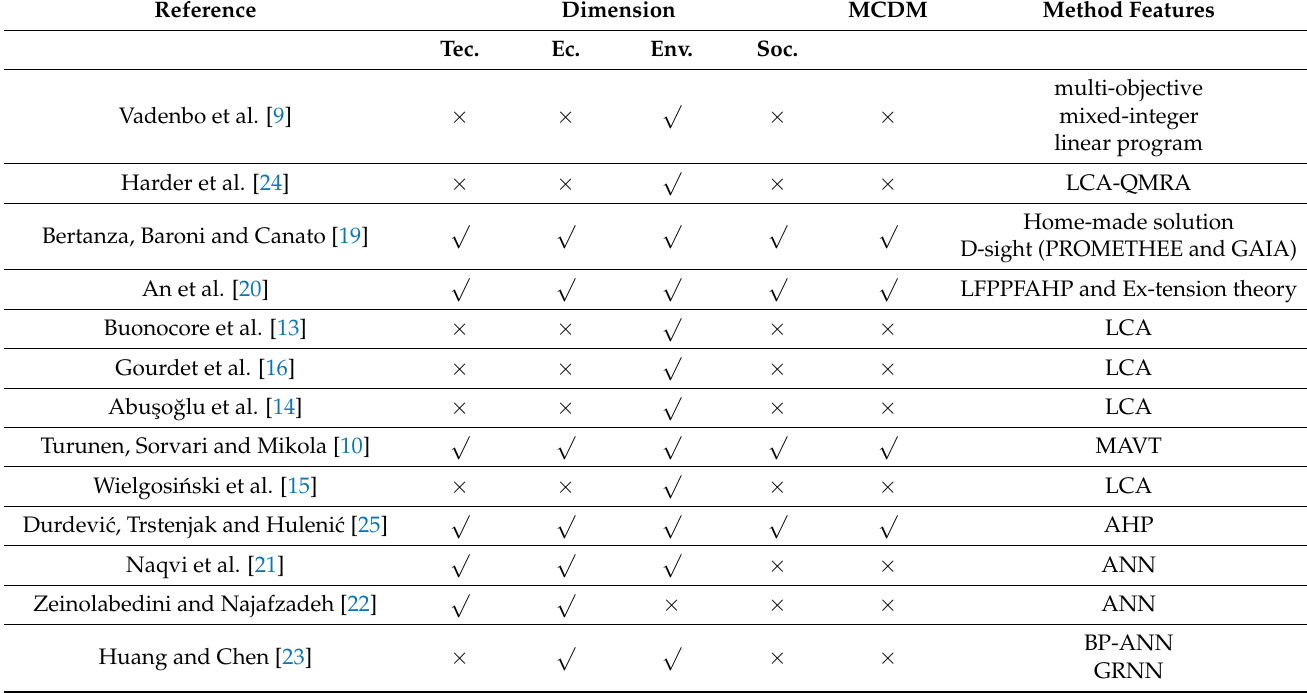
Table 1. Summary of the scientific research identified, classified according to dimension evaluated, features of the method adopted, and possible application of multiple-criteria